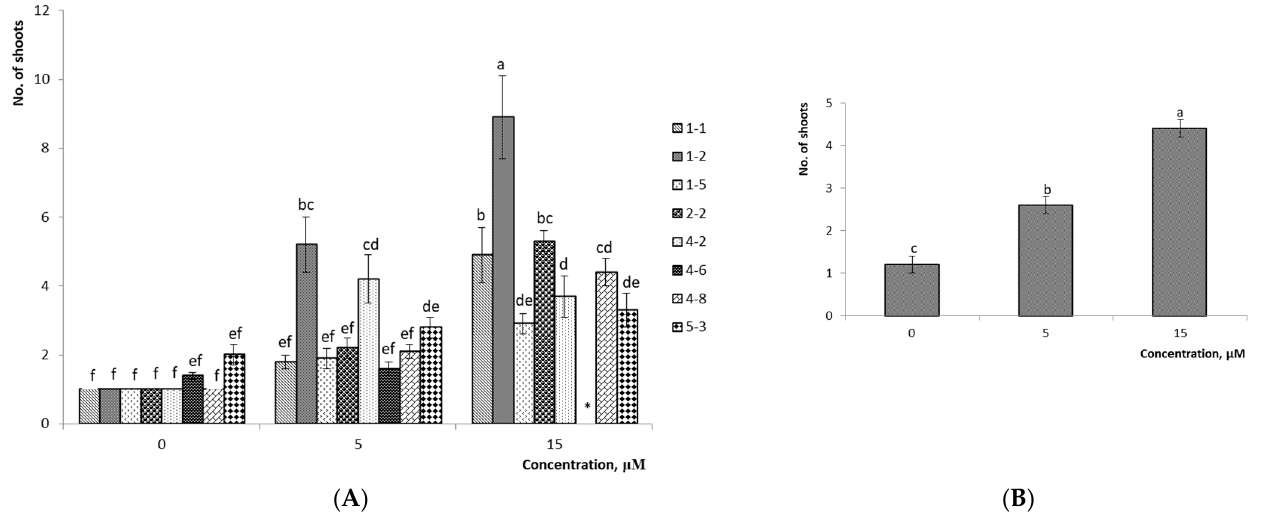
Figure 4. Effect of 2iP concentration on the multiplication rate of V.ul. 8 × ‘NC’: ( A ) detailed analysis of values of hybrid variants; ( B ) average values of hybrid variants. Means followed by the same letter are not significantly different according to the LSD at p ≤ 0.05. Note: *—conglomerate of shoots variant No. 4-6; 1-1, 1-2, 1-5, 2-2, 4-2, 4-6, 4-8, 5-3—variant Nos. 1-1,